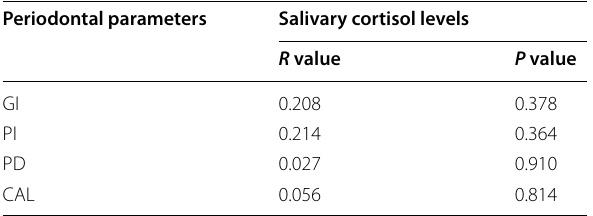
Table 3 Pearson correlation between clinical periodontal parameters and cortisol